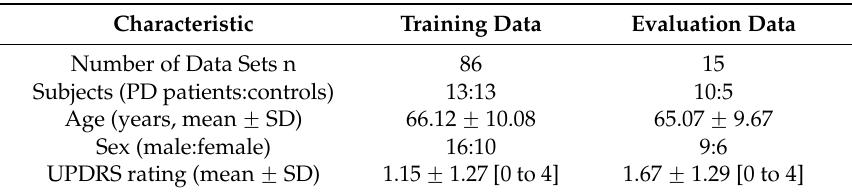
Table 4. Training and evaluation